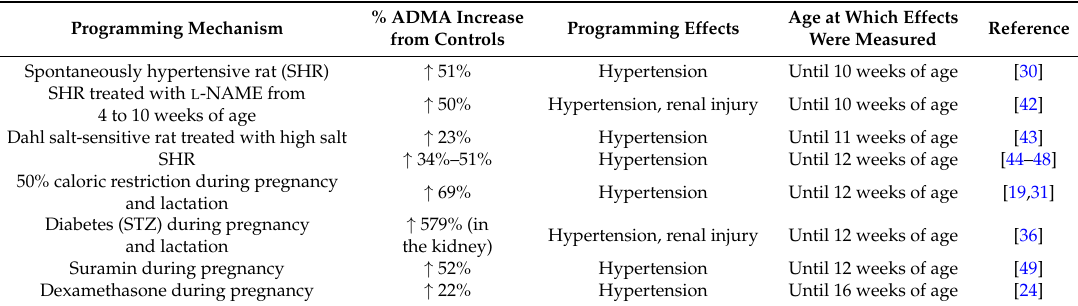
Table 1. ADMA related NO-ROS imbalance in programmed hypertension